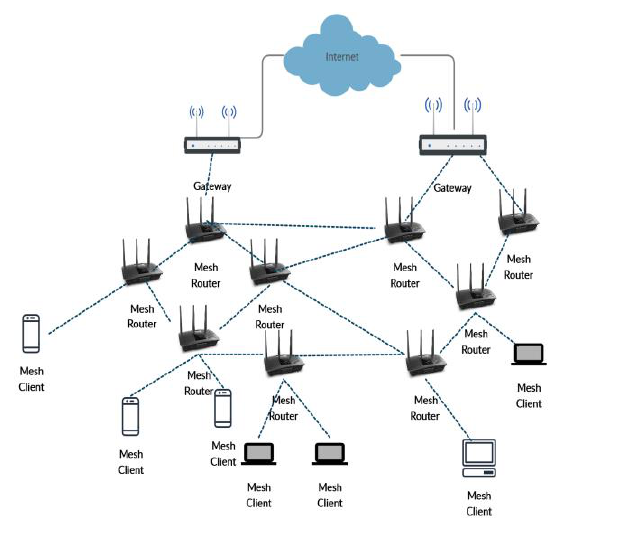
Figure 1 . A wireless mesh network Multicast [2] is the communication system that spreads the datagram’s to a set of devices, the device groups are